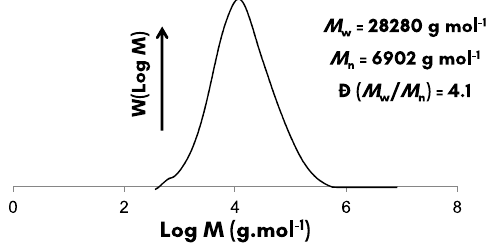
Figure 5. Molar mass distribution of the HD-SBR#01 with 4 wt.% of tert-dodecyl mercaptan (t-DM).